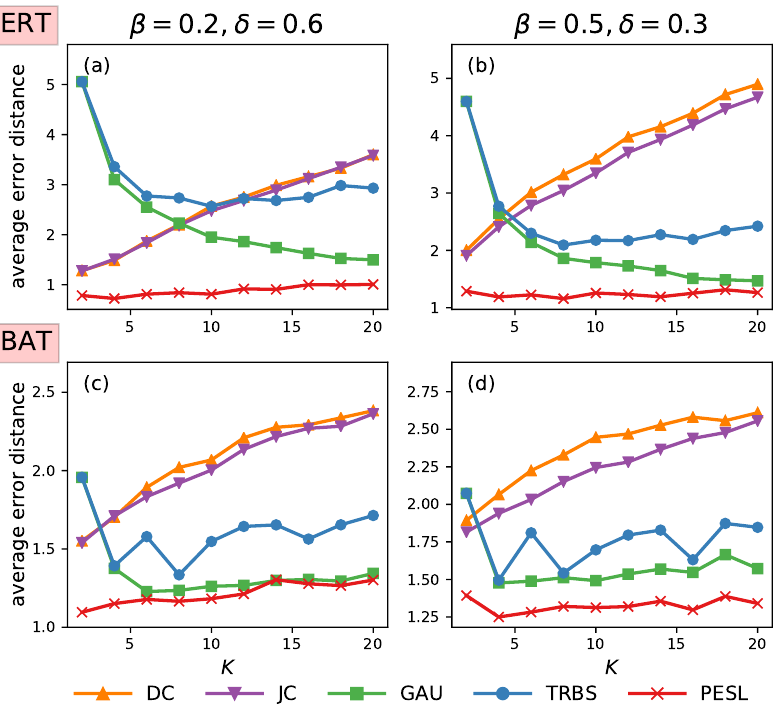
Figure 4. The relationship between source localization accuracy and the number of observers in tree networks. ( a , b ) represent the relationship between average error distance and the number of observers in ERT under β = 0.2, δ = 0.6 and β = 0.5, δ = 0.3 respectively. ( c , d ) represent the same results in BAT. The abscissa represents the number of observers K